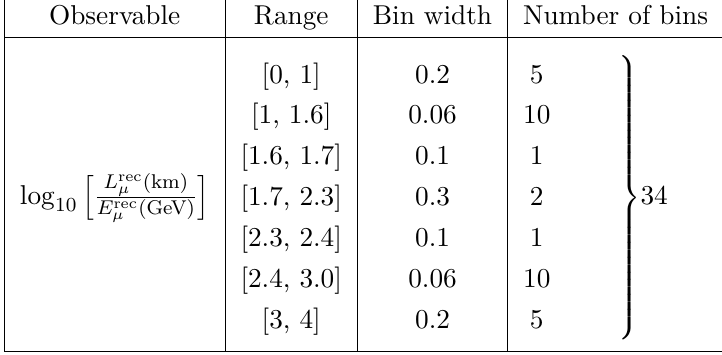
Table 3 . The binning scheme of log